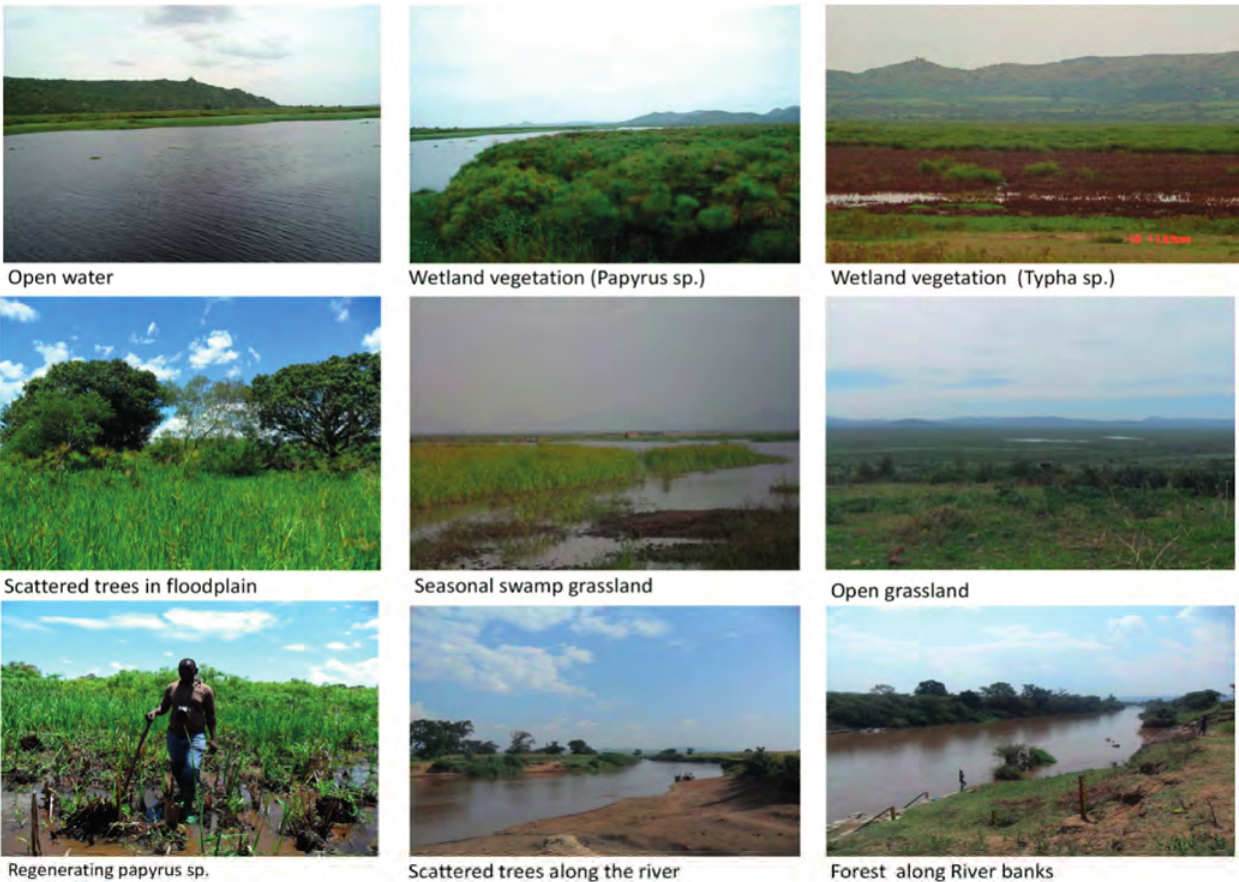
Figure 3. Photos showing different land cover types in the